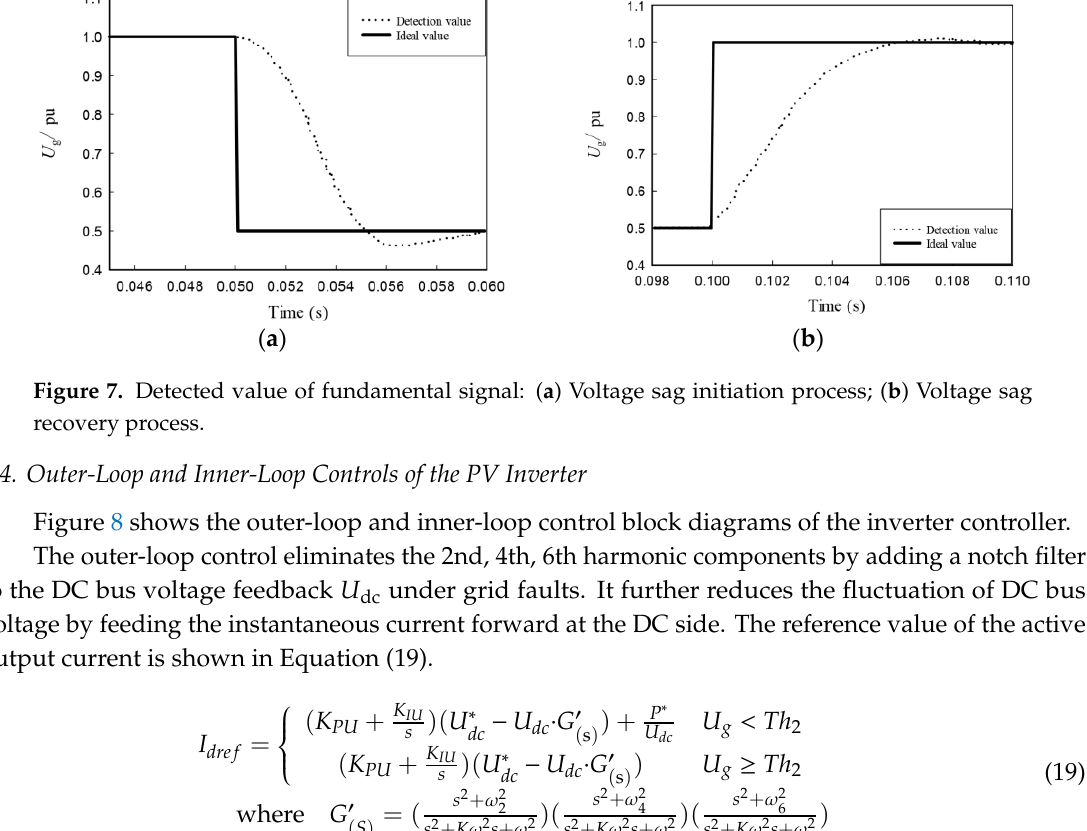
Figure 6. Principle diagram of voltage sag fault detection.